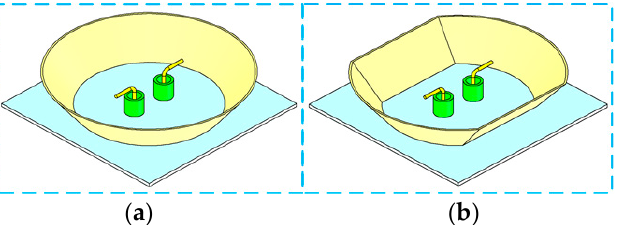
Figure 7. The proposed antenna’s high-gain design procedure. ( a ) antenna with a cone cavity; ( b )